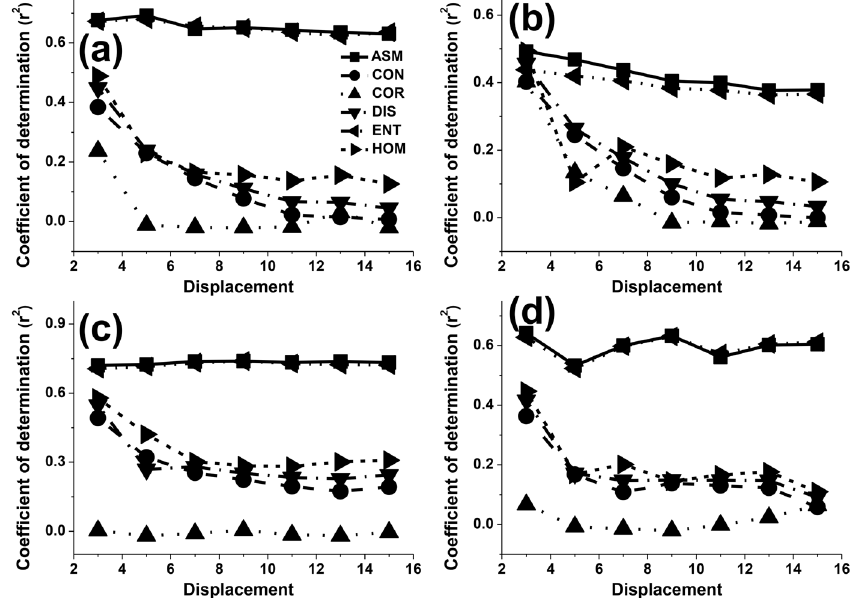
Figure 3. The effect of the displacement parameter on the values of adjusted r 2 for different texture features when the orientation was set to 0° and the window size was set to 3 × 3 pixels ( a ); when the orientation was set to 0° and the window size was set to 15 × 15 pixels ( b ); when the orientation was set to 90° and the window size was set to 3 × 3 pixels ( c ); when the orientation was set to 45° and the window size was set to 3 × 3 pixels ( d